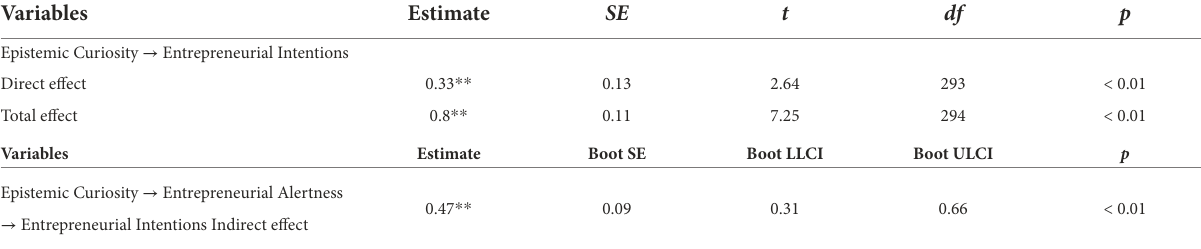
TABLE 7 Results for mediation analysis from epistemic curiosity to entrepreneurial alertness to entrepreneurial intentions.